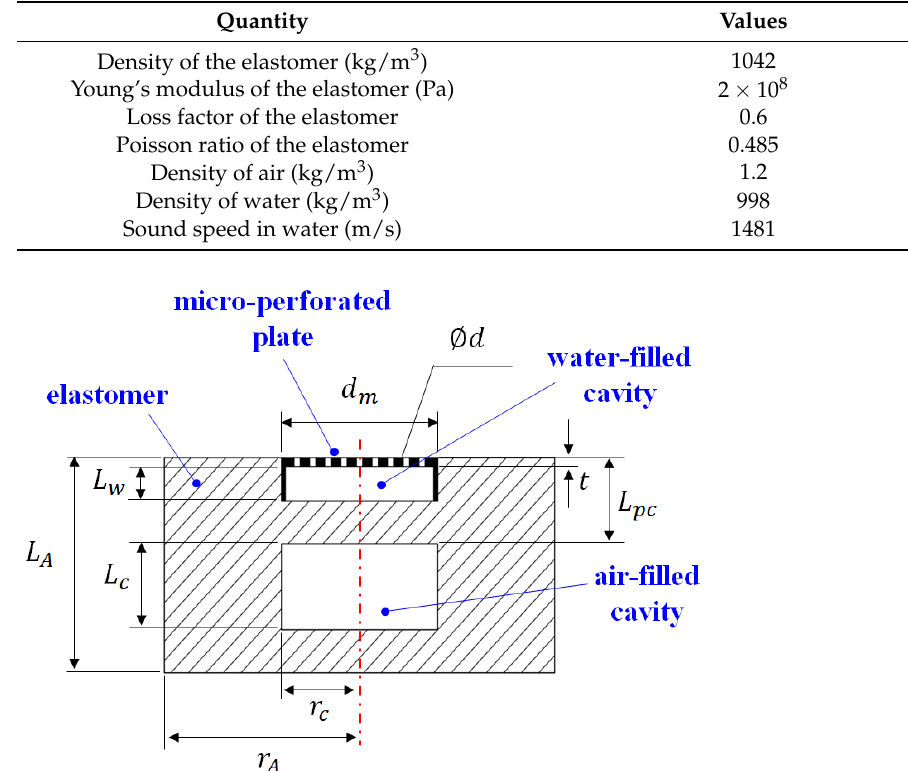
Figure 6. Schematic and geometric parameters of the hybrid sound-absorbing metastructure in finite-element simulations. Table 1. Parameters considered for the substrate of the developed metastructure [8].